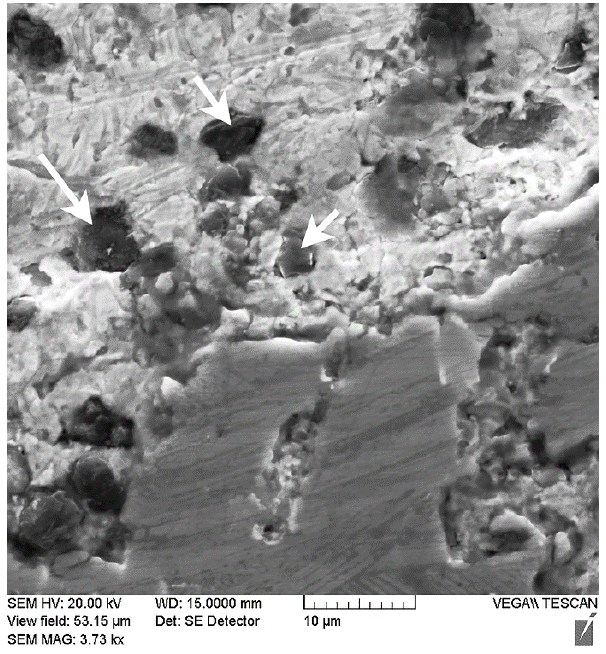
Figure 5. The structure of the lead sublayer with carbon inclusions (indicated by arrows).